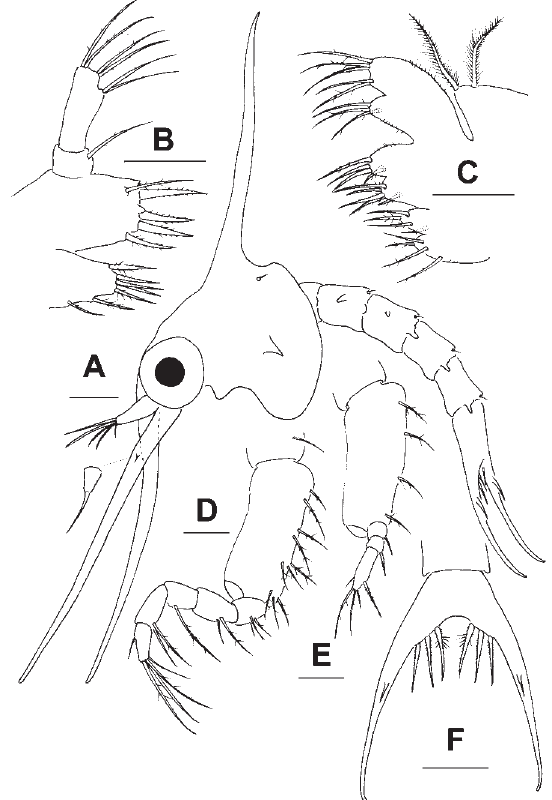
Fig . 4. – Dyspanopeus sayi. First zoea. Lateral view (A); maxil- lule (B); maxilla, endites and endopod (C); first maxilliped, exopod omitted (D); second maxilliped, exopod omitted (E); Telson, dorsal view (F). Scale bar of A and F: 100 μm; of B-E: 50 Table 3. – Dyspanopeus sayi (Smith, 1869). Morphological and biometric characteristics of first zoea. Abbreviations: a, aesthetascs, AL, antenna length (protopod process); CL, carapace length; cox, coxa; mxpd, maxilliped; pd, posterodorsal; RDL, rostrodorsal length; RL, rostral spine length; s, setae; CW, carapace width; * described from figure.